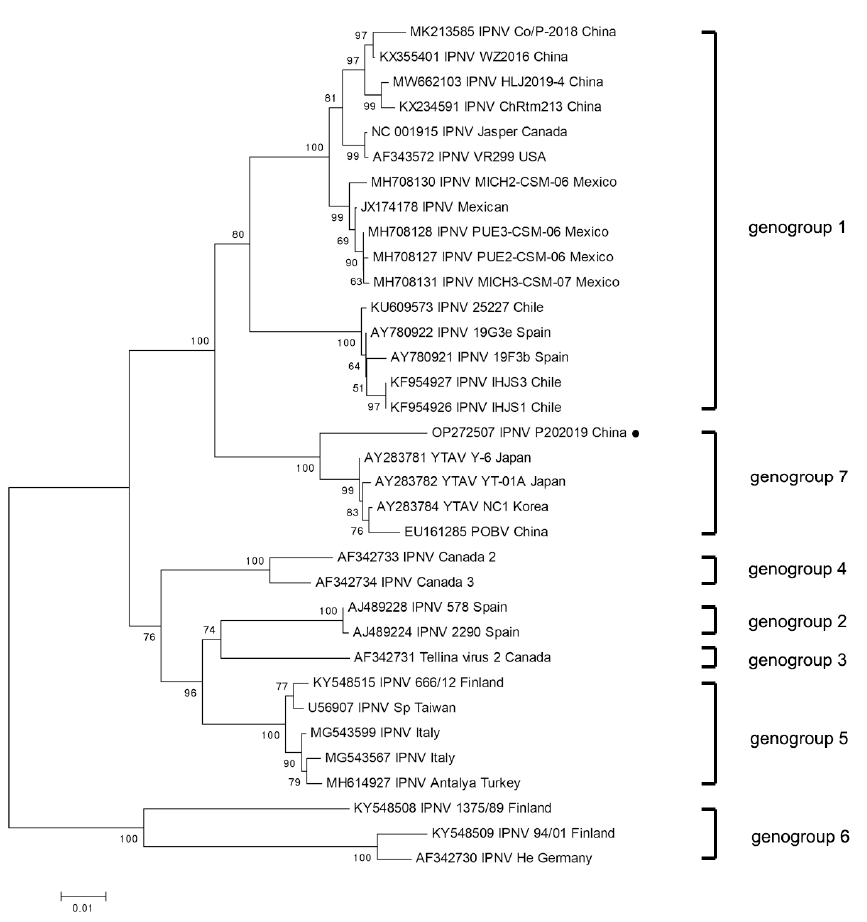
Figure 2. Phylogenetic analysis of IPNV-P202019 and the other representative aquabirnavirus based on nucleotide sequences of the VP2 genome. The tree was constructed by the neighbor-joining method. Bootstrap values are indicated for each node from 1000 resampling. The figure shows the name of the viruses, GenBank accession number, and country. The solid black circle represents the IPNV-P202019 isolated in this study.